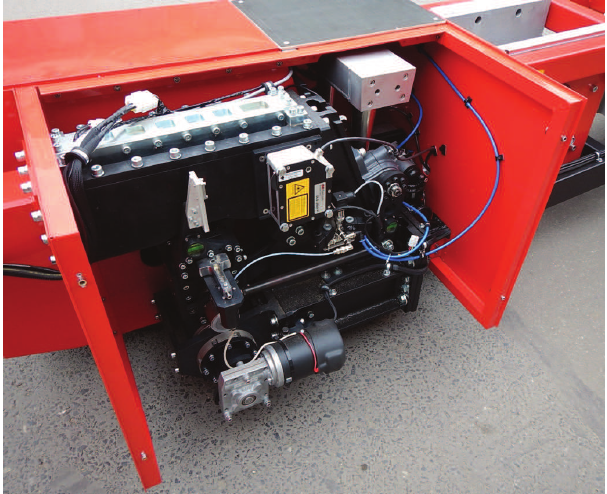
Fig. 7. Tyres for electric cars; on the left – tyre of typical size for modern cars with conventional design, on the right – tyre for electric cars con- structed in nonorthodox